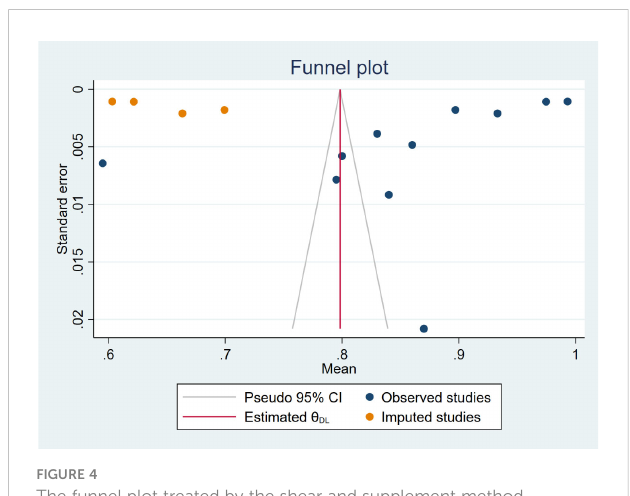
FIGURE 4 The funnel plot treated by the shear and supplement